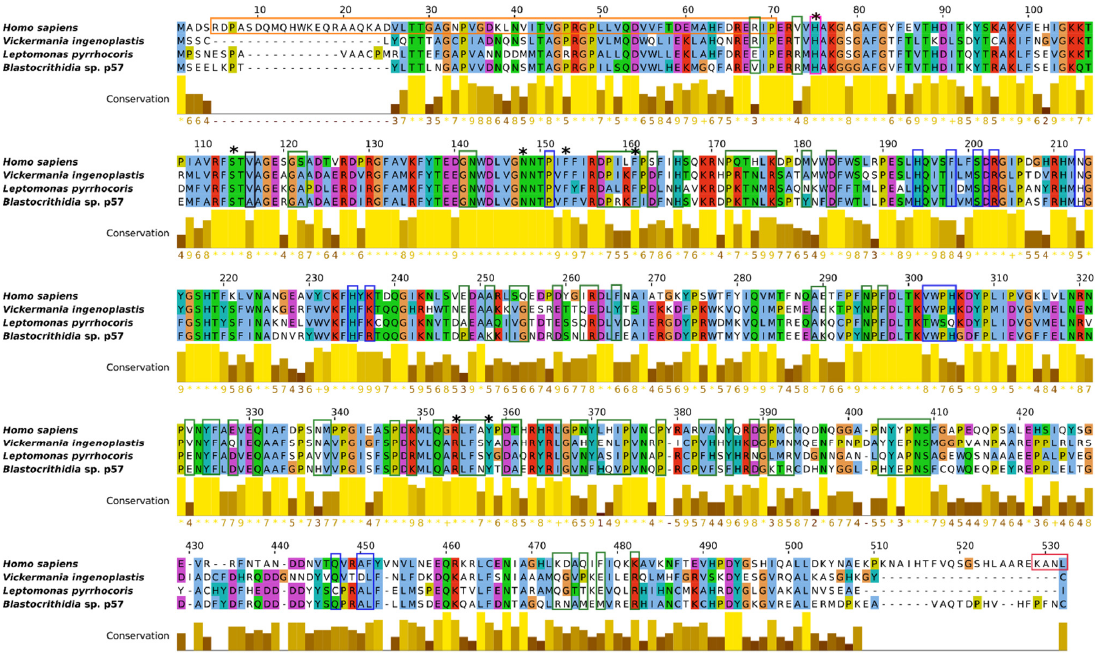
Figure 2. Multiple alignment of catalase amino acid sequences for three trypanosomatids and well-studied Homo sapiens (selected as a reference). Predicted domains and sites: black asterisk, heme binding pocket; blue box, NADPH binding site; green box, tetramer interface; orange box, N-terminal threading arm; pink box, distal histidine binding site for 3-AT inhibitor; red box, peroxisomal targeting signal. The Val116 is boxed in black. Conservation color below alignment follows the ClustalX scheme. The numerical index indicates the level of conservation for each column of the alignment. The score is shown below the histogram, with higher score denoting higher level of conservation. The conserved positions with a score of 11 are indicated by yellow asterisks. Positions with a score of 10 (possessing mutations but retaining all physicochemical properties) are marked by ’+’.